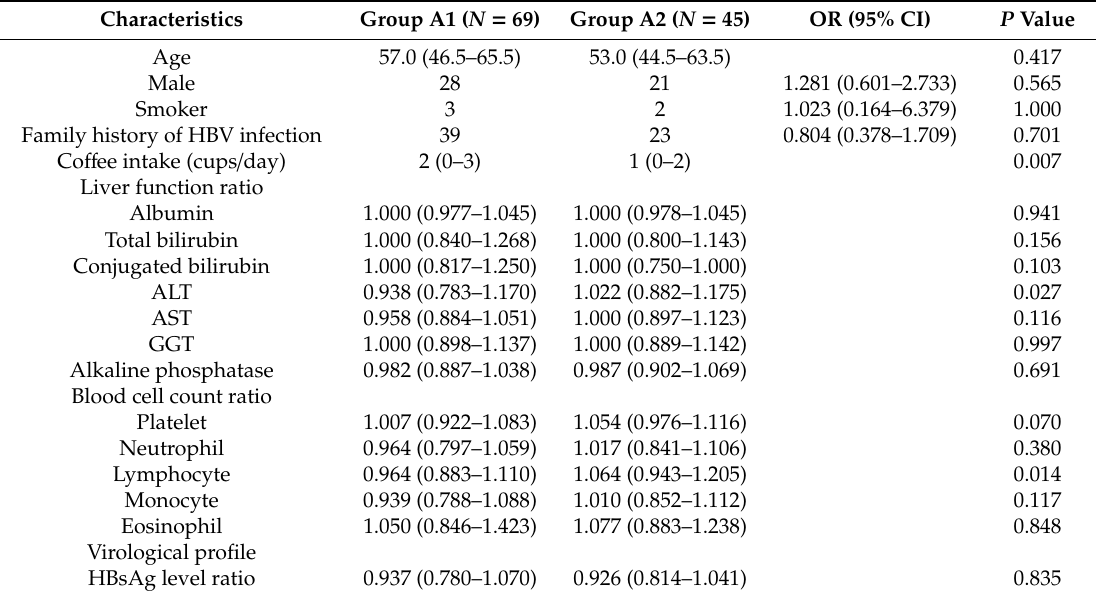
Table 1. E ff ects of demography, liver function, blood cell profile and HBsAg level on HBV DNA level by univariate